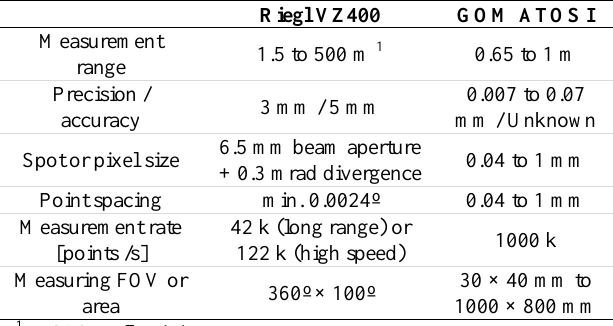
Table 1. Specifications of Riegl VZ400 and GOM ATOS I.